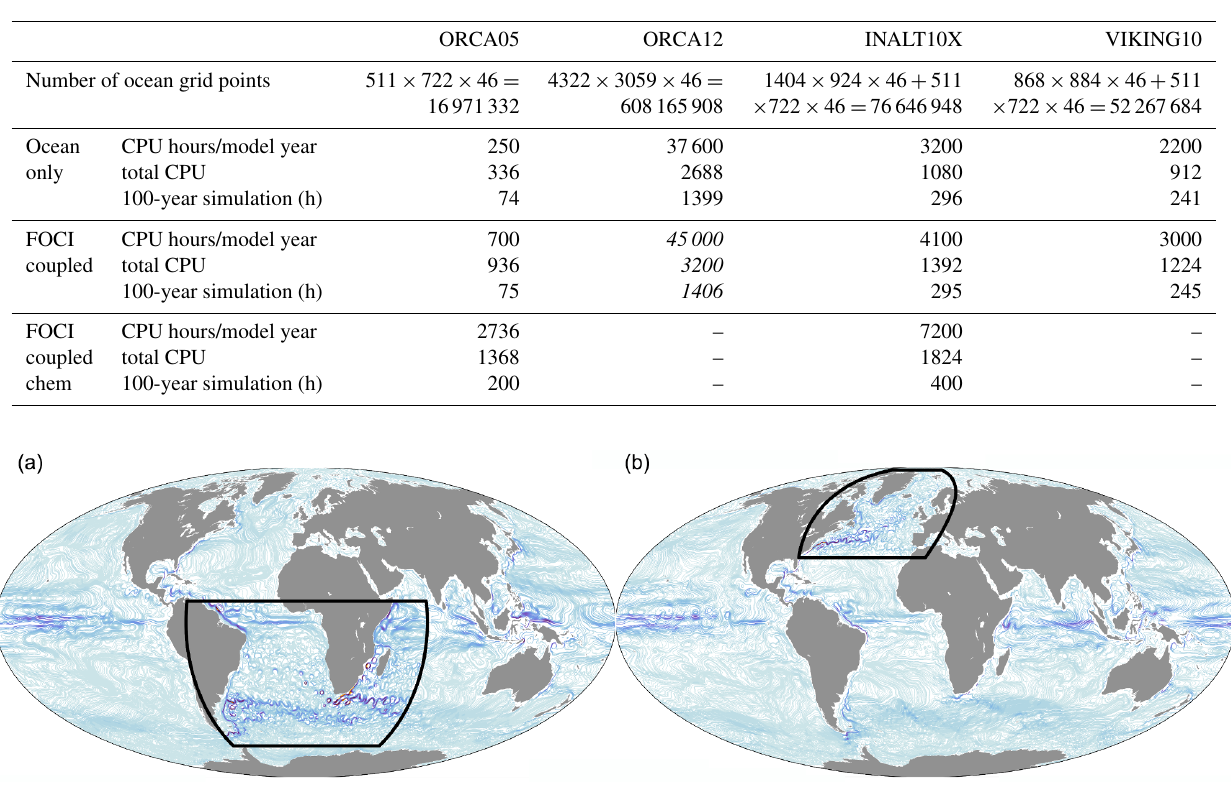
Figure 2. Snapshots of upper ocean current speed (upper 100m averaged) for two separate ocean nest configurations, where ocean resolu- tion refines from 1 / 2 to 1 / 10 ◦ in the highlighted regions. (a) INALT10X, South Atlantic nest between 9 ◦ N and 63 ◦ S, 70 ◦ W and 70 ◦ E; (b) VIKING10, North Atlantic nest between 30 and 85 ◦